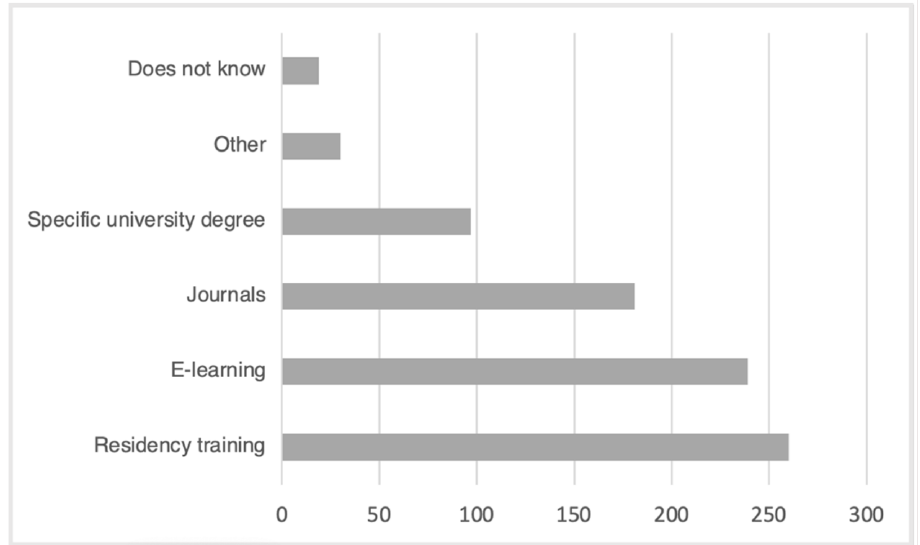
Figure 2. Desired pharmacogenetic training